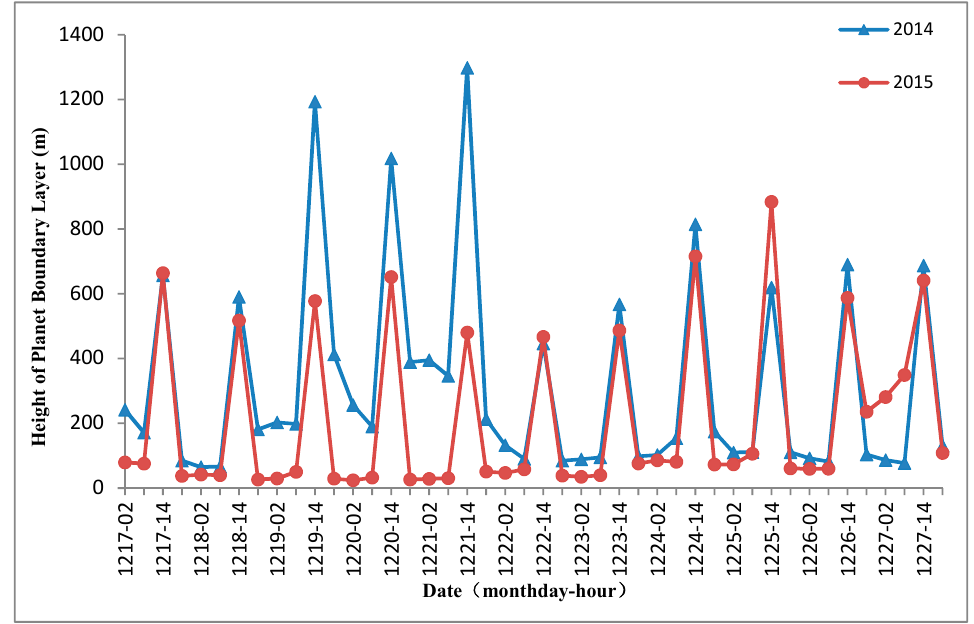
Figure 8. Comparison of average height of planet boundary layer from 17 December–27 December between 2014 and 2015.